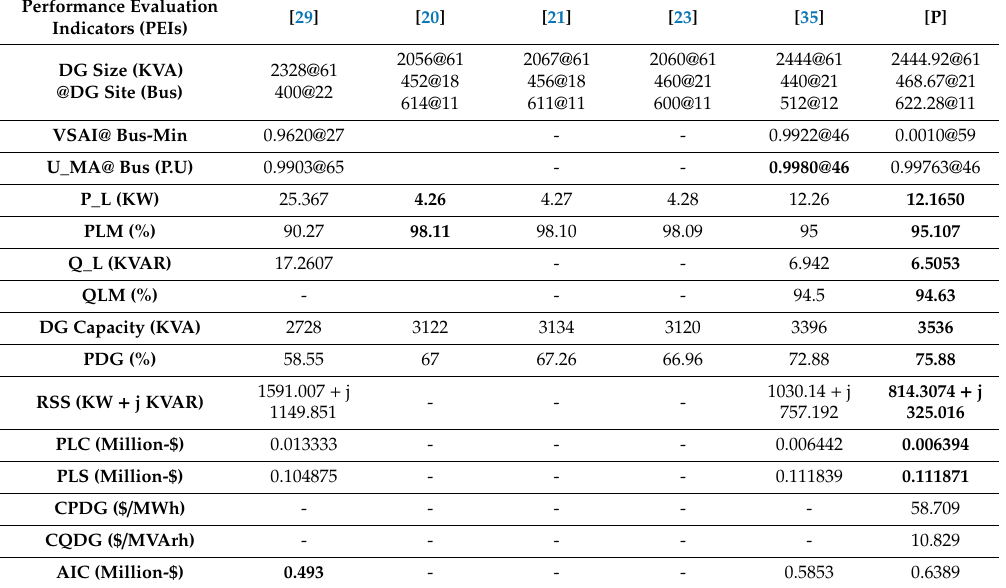
Table 16. Comparisons of results with various scenarios of C6 / S2 for a 69-bus test system (DG@PF = 0.82 ±